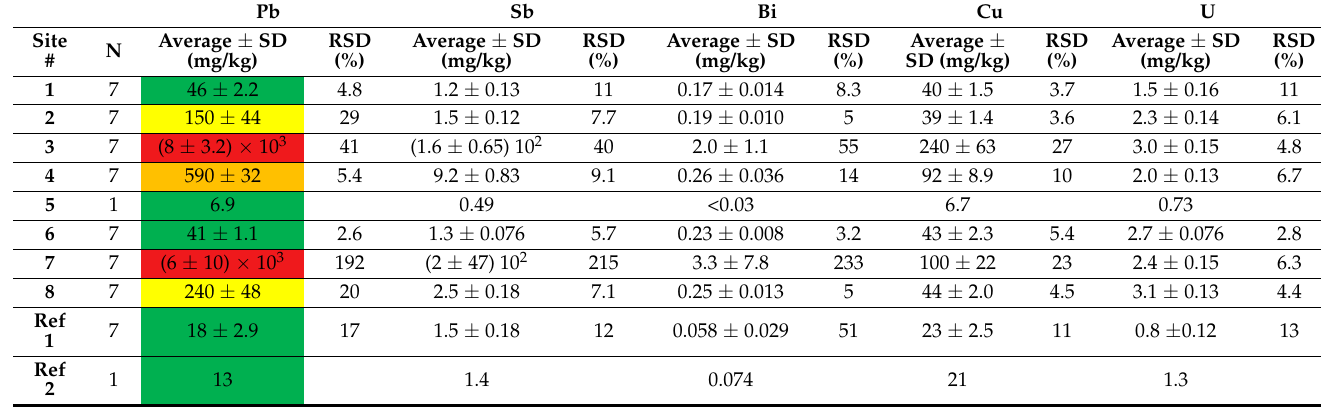
Table 1. Average concentration of copper (Cu), antimony (Sb), lead (Pb), bismuth (Bi), and uranium (U) in surface soil (0–2 cm) collected in the Greek refugee camp Mavrovouni. N indicates the number of replicates. The color code specifies the action limits with respect to concentration of Pb in soil in kindergartens, playgrounds, and schools according to the Norwegian Environment Agency [25]. Green: 100 mg/kg—Quality criteria normal. Yellow: 100–300 mg/kg—No action indicated. Orange: 300–700 mg/kg—Immediate action should be considered and the site prioritized in the action phase. Red: 700–2500 mg/kg—Immediate action should be taken. See Figure 1 for location of sampling sites 1–8 and reference sites Ref 1 and Ref